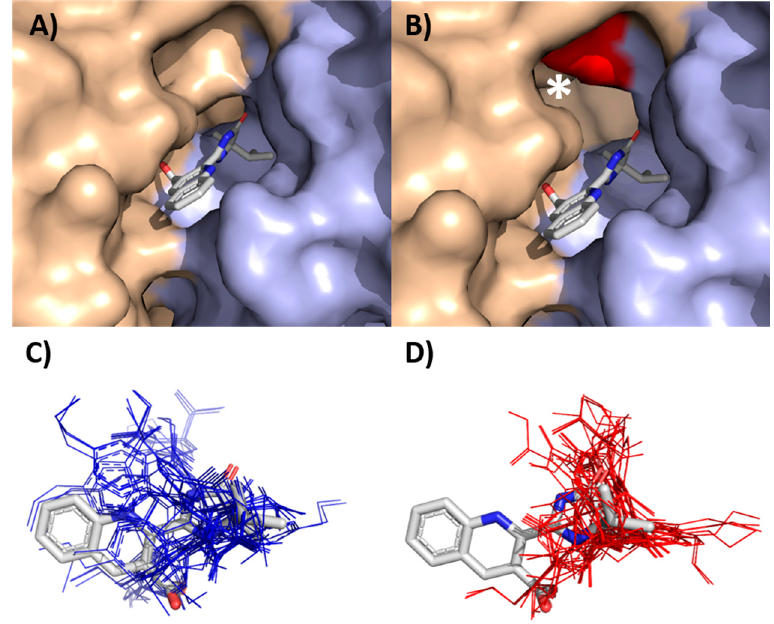
Figure 5. Docking of imazamox to ( A ) S-ALS and ( B ) R-ALS from wild poinsettia. The herbicide binding site is at the interface between two ALS subunits shown in pale yellow and light blue. Imazaquin is positioned in the channel according to coordinate from 1Z8N crystal structure. The leucine mutation is shown in red in panel B. The white asterisk points to the larger opening in the substrate channel resulting from the Trp to Leu mutation. Distribution of imazamox docking poses in ( C ) S-ALS in blue and ( D ) R-ALS in red, relative to the position of imazaquin from the 1Z8N crystal structure.